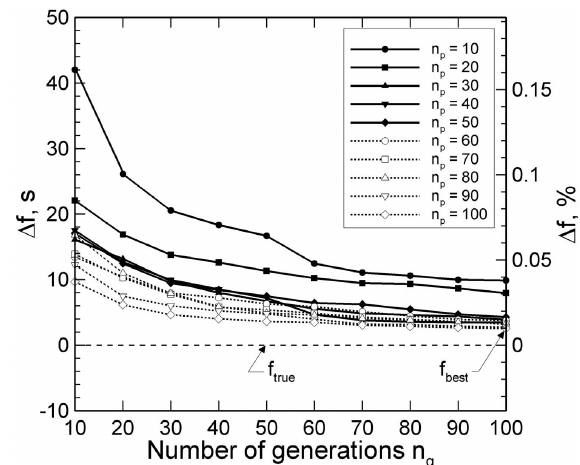
Figure 7. Optimal solutions varying with the population size n p and the number of generations n g . (cid:49)f means the difference in flight time between the optimal solution f and the true-optimal solution f true ( = 25994 . 0s). The (cid:49)f (in %) is calculated as ((cid:49)f/f true ) × 100. The flight time of the best solution is f best = 25996 . 6s (for n p = 100 and n g = 100, (cid:49)f < 3 . 0s (less than